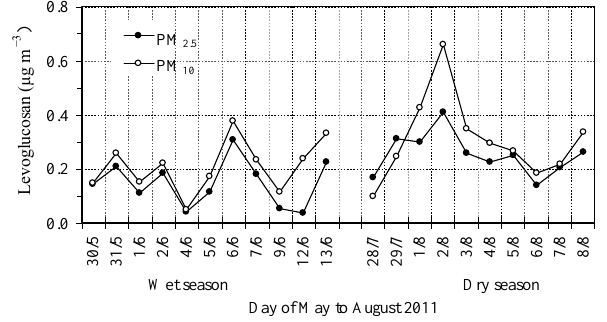
Fig. 6. Temporal variations of levoglucosan in PM 2 . 5 and PM 10 at Morogoro during the wet and dry seasons.